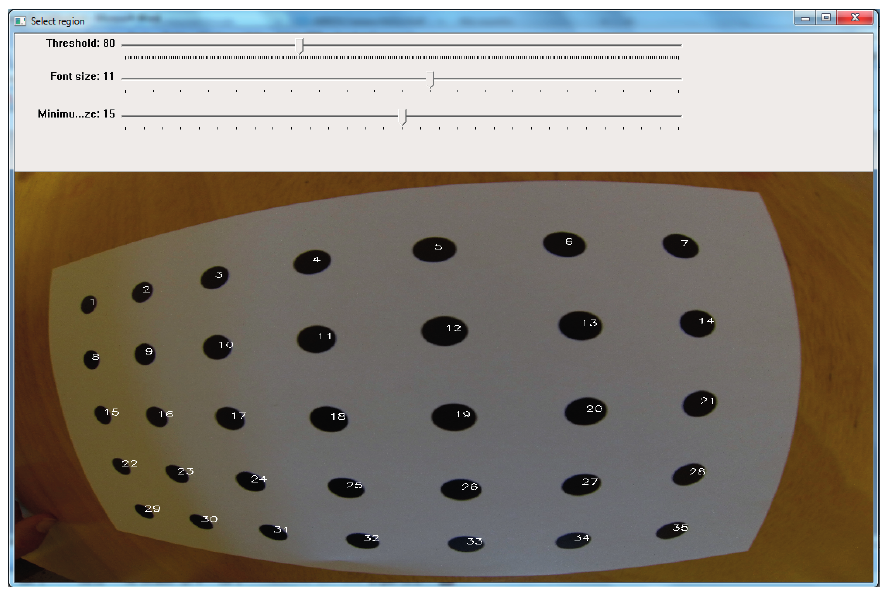
Figure 10. Since the control points are identified correctly the software displays the numbers of control points on the original calibration